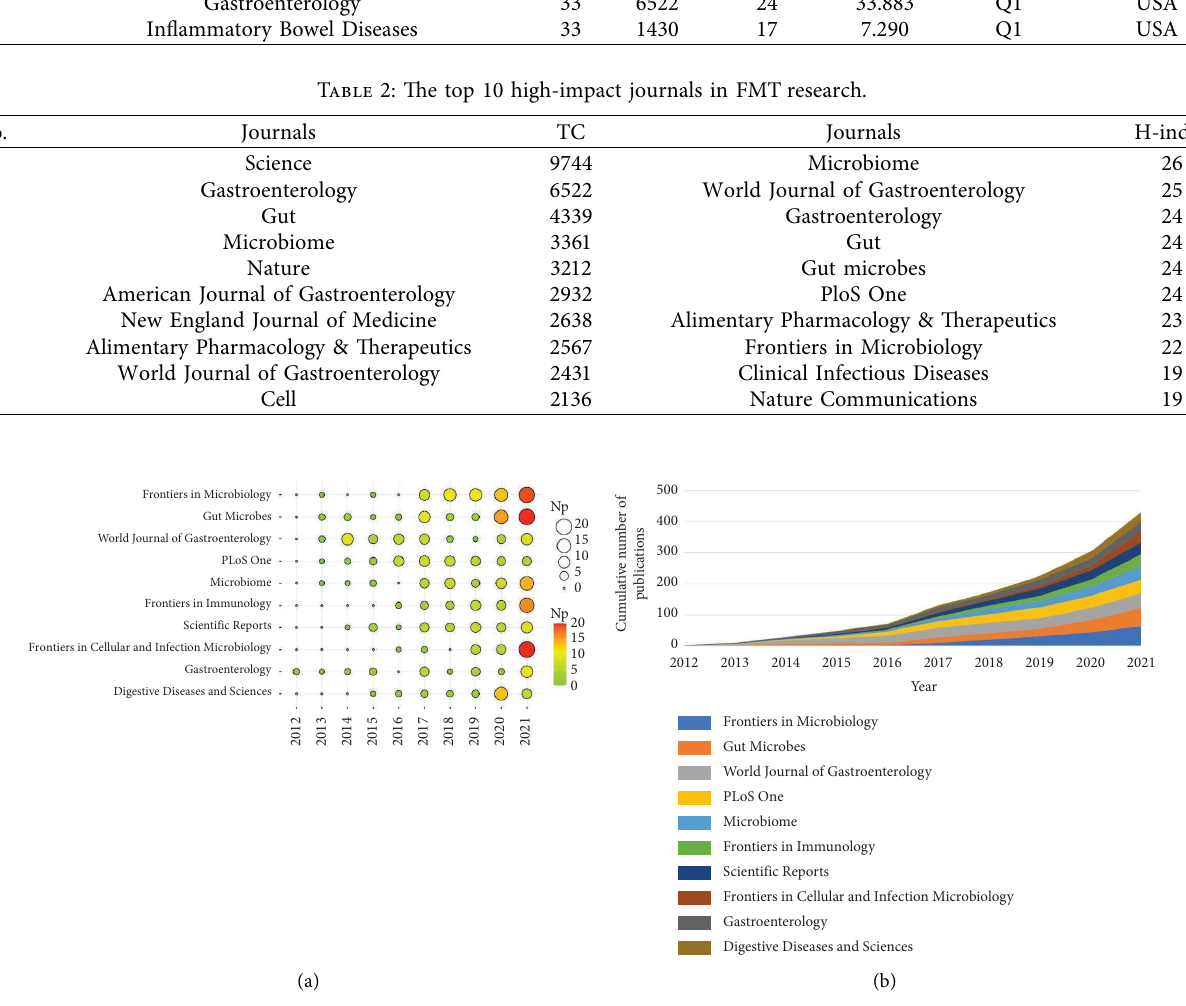
Figure 3: (a) Annual output of the top 10 journals in FMT. (b) Cumulative output of the top 10 journals in